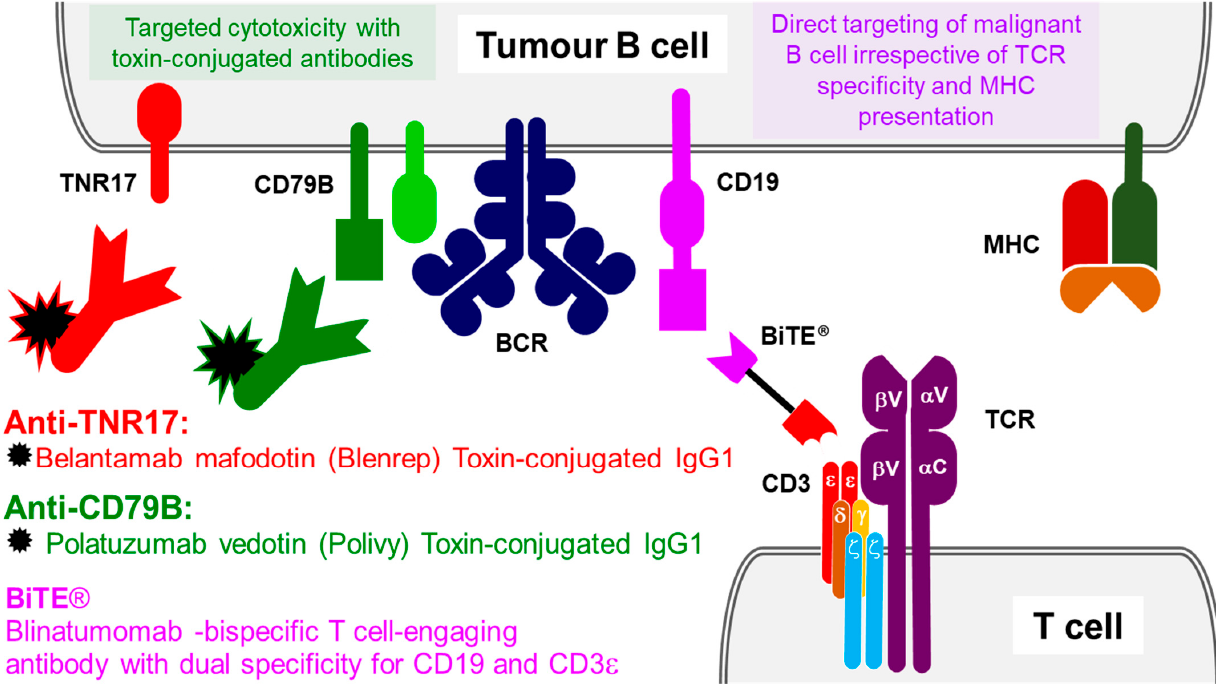
Figure 2. Antibody therapeutics targeting B-cell and T-cell antigens. Targeting tumour B-cells with monoclonal antibodies against tumour necrosis factor receptor superfamily member 17 (TNR17) conjugated to anti-mitotic maleimidocaproyl monomethyl auristatin F (mcMMAF) (coloured red). Targeting tumour B-cells with monoclonal antibodies against B-cell antigen CD79B of the BCR complex, conjugated to anti-mitotic monomethyl auristatin E (MMAE) (coloured green). Bispecific T-cell-engaging antibodies (BiTE) has dual specificity for CD19 and CD3 and redirects polyclonal cytotoxic T lymphocytes toward the tumour.